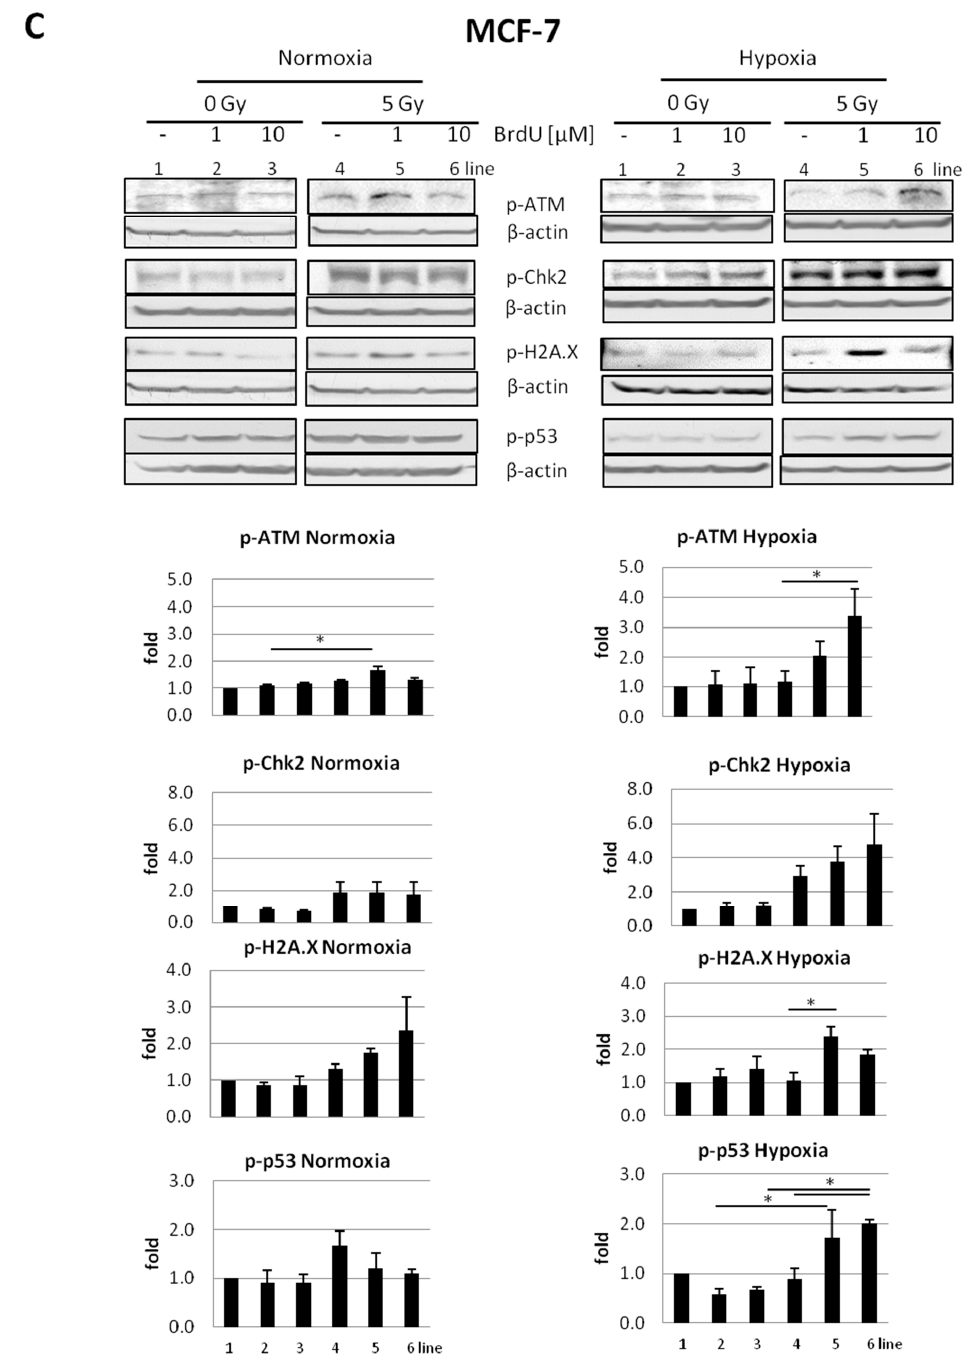
Figure 5. Effect of treatment with BrdU and/or exposure to ionizing radiation of cells in normoxic or hypoxic conditions. ( A ) Investigation of HIF-1 α hypoxia marker in MCF-7 and PC3 cells un- treated/treated (1 or 10 µ M) with BrdU and unexposed/exposed to ionizing radiations (5 Gy) under hypoxia and normoxia conditions. Status of p-ATM, p-Chk2, p-H2A.X and p-p53 in ( B ) PC3 and ( C ) MCF-7 cells untreated/treated (1 or 10 µ M) with BrdU and unexposed/exposed to ionizing radiations (5 Gy) under hypoxia and normoxia conditions. The blots were stripped and reprobed with anti- β -actin antibodies to normalize for differences in protein loading. Densitometric data, corrected for loading control, are graphed below (mean ± SE; n = 2–3). The statistical significance of differences was determined by one-way ANOVA followed by Sidak’s multiple comparison test, and * p <